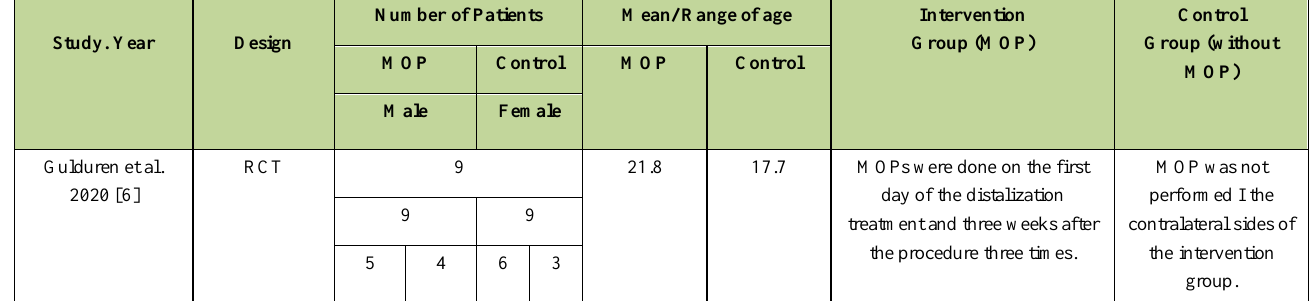
Table 2. Human studies were selected for systematic review and meta-analysis.